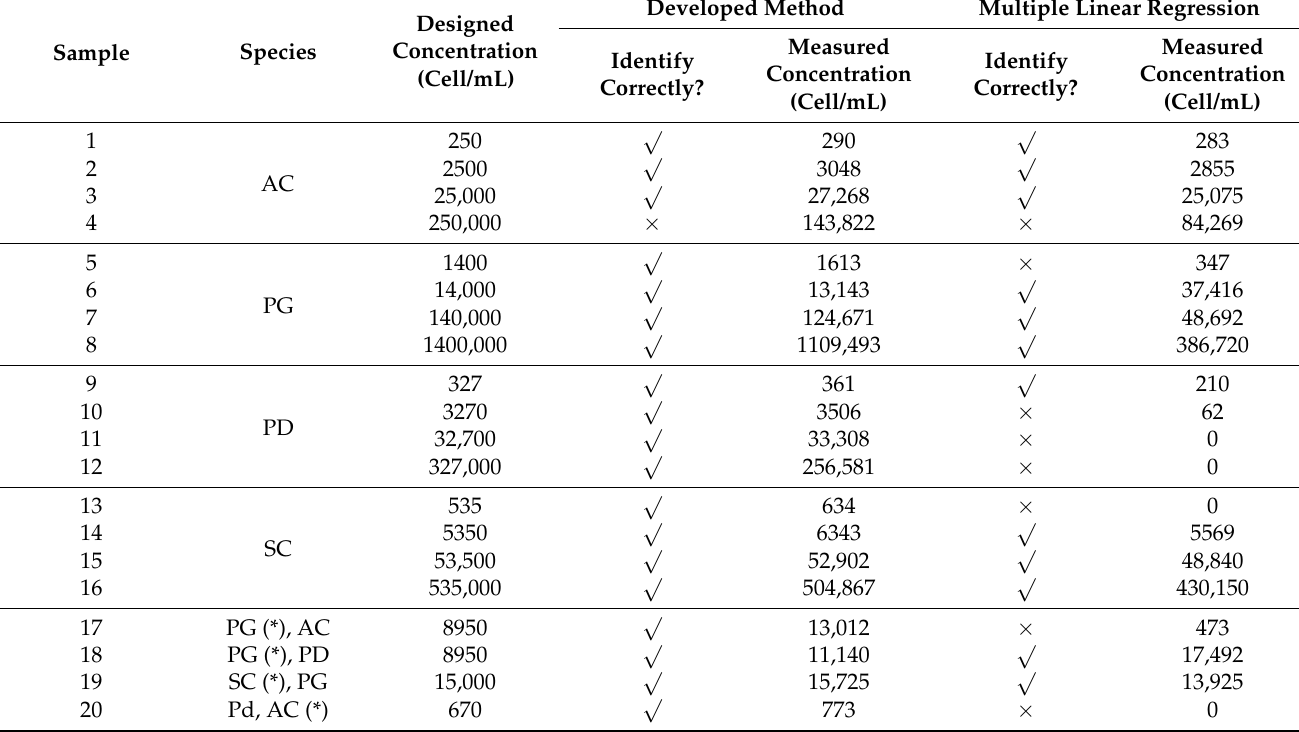
Table 8. Comparison of our method with multiple linear